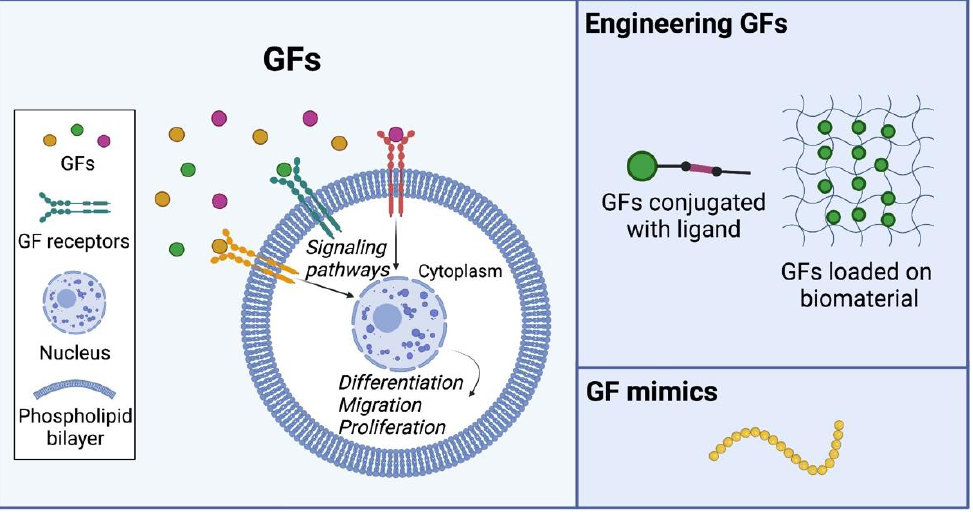
Figure 4. Engineering GFs and artificial GF mimics.